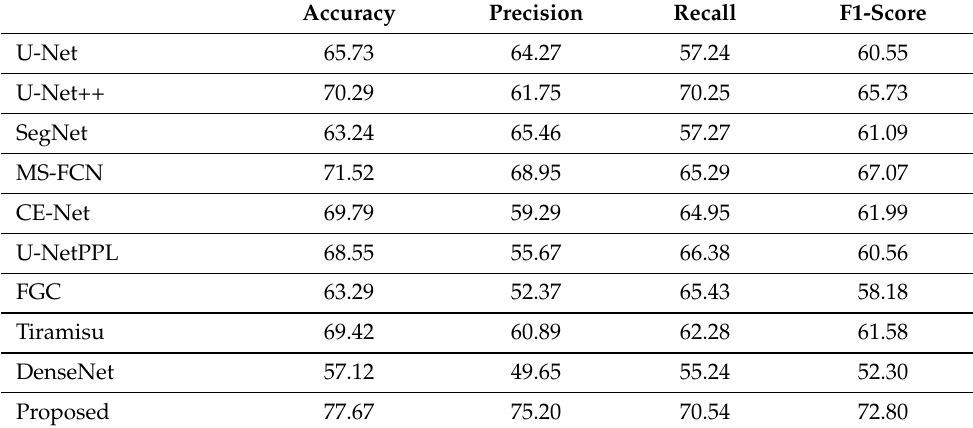
Table 3. Performance comparison of different deep learning